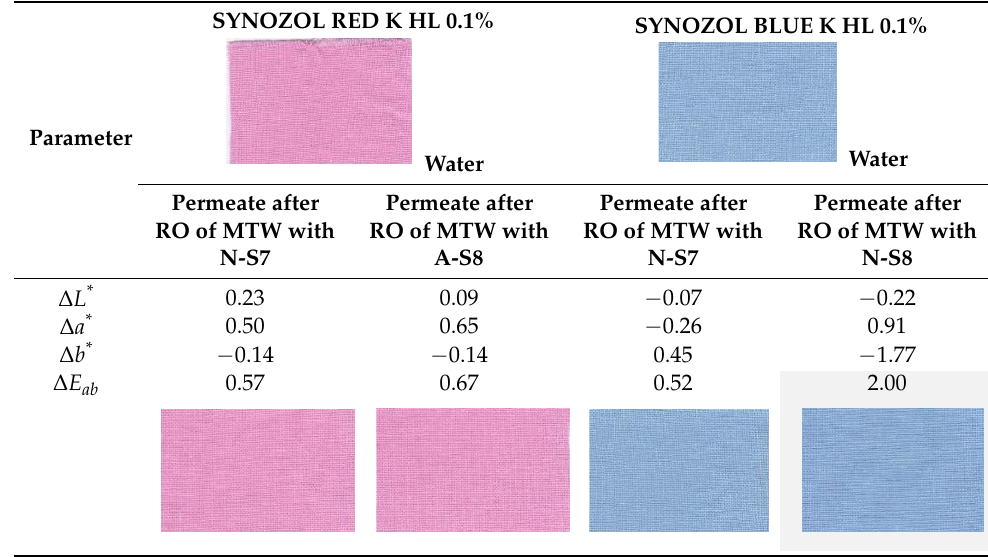
Table 5. Color difference ∆ E ab of dyed samples with a color intensity of 0.1% in pure water and treated MTW: knitted fabric 100% CO.